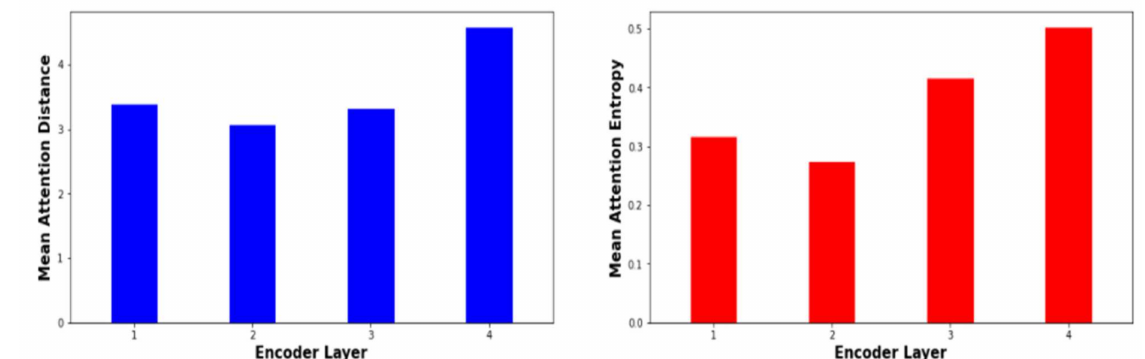
Figure 8. Variation of the average mean attention distance and variation of the average entropy of head attention distribution with respect to each encoder layer for the suggested